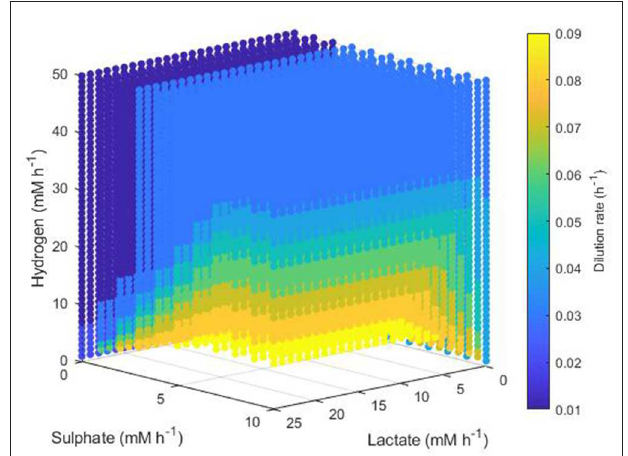
FIGURE 8 | Maximum dilution rates (h − 1 ) under which the outcome of the model was survival of the acetogen only. The axes indicate the inflow rate of each of the three substrates, and the colored points represent combinations of these inflows that resulted in survival of the acetogen only at the dilution rate shown on the color bar.